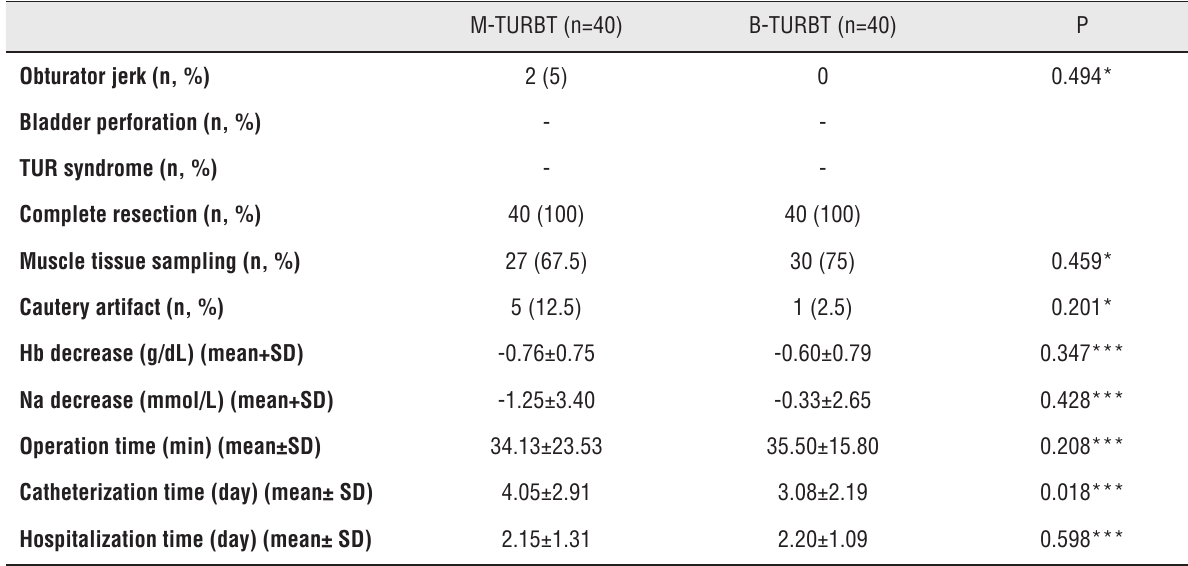
Table 2 - Perioperative